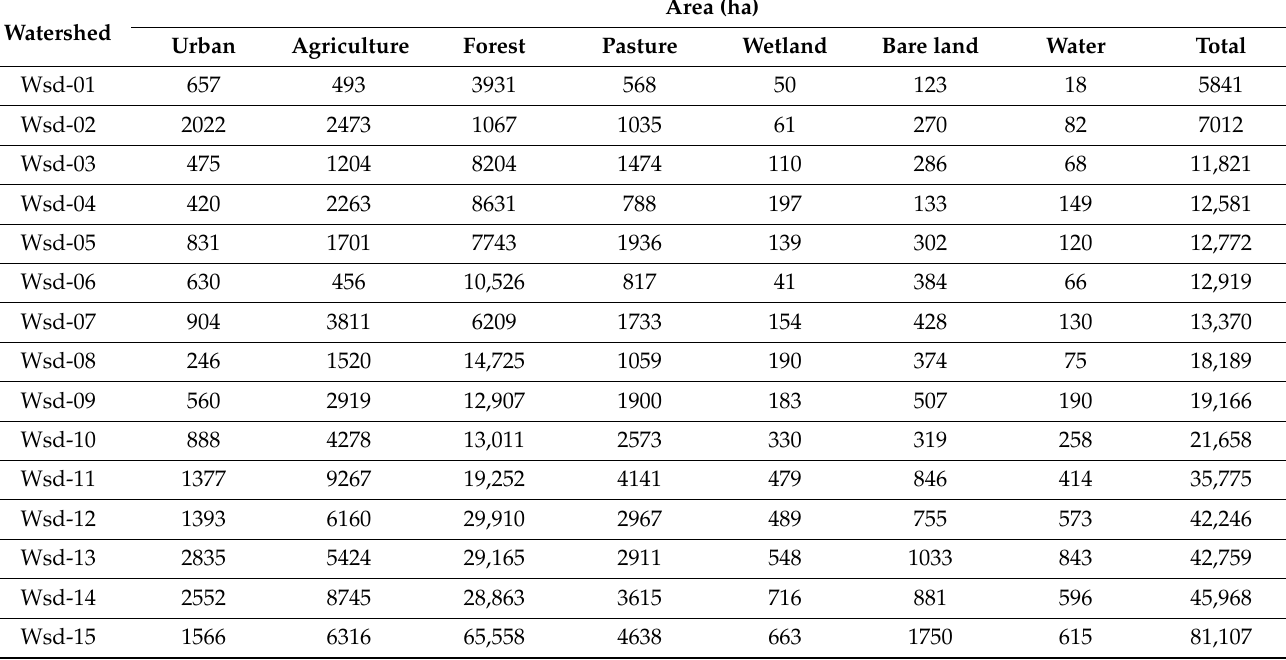
Figure 3. Locations of studied watersheds and rain gauge stations. Table 2. Land use in watersheds.